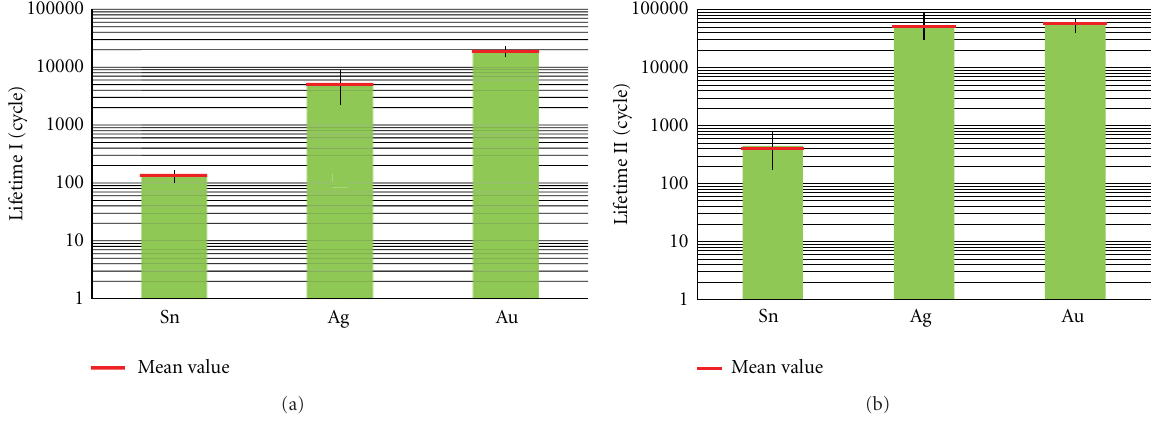
Figure 5: (a) Lifetime I of contacts with di ff erent coating materials. (b) Lifetime II of contacts with di ff erent coating